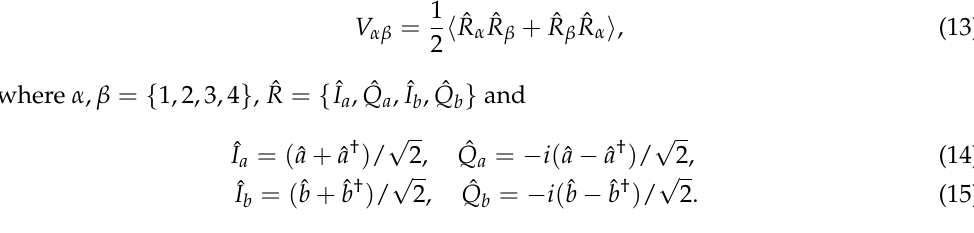
Figure 5. The second-order coherence functions g {− 0.5, − 0.25,0.25,0.5 } Φ